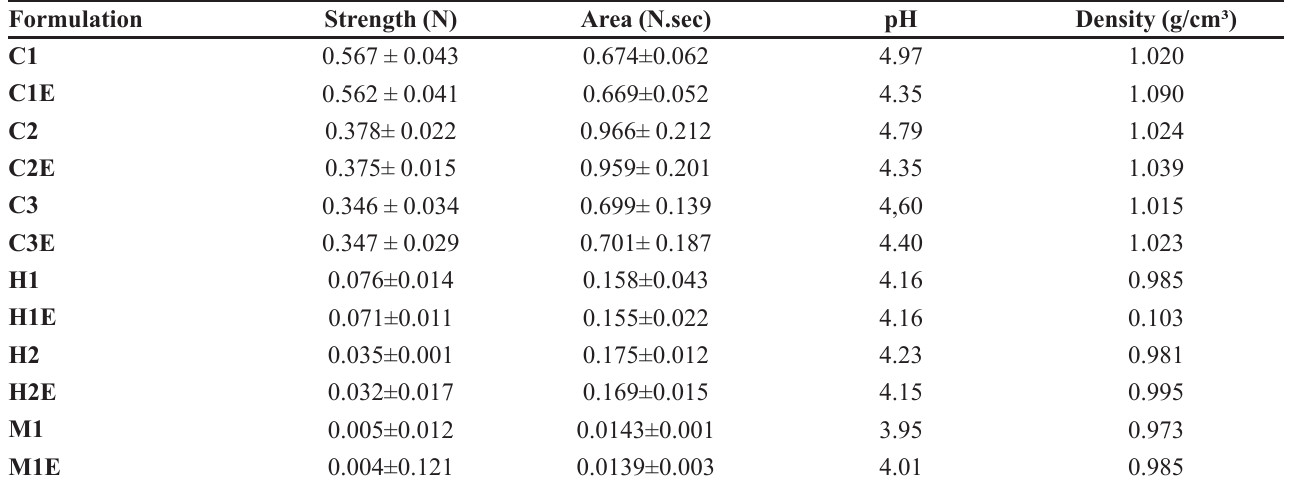
TABLE III - Bioadhesion parameters (strength and area), pH and density values of the formulations.